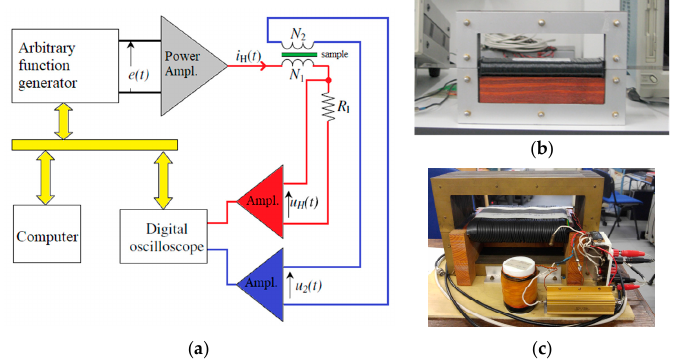
Figure 1. Digital wattmeter set-up ( a ) block-diagram [14], ( b ) first yoke for 30 × 300 mm 2 samples, ( c ) second yoke for 60 × 300 mm 2 samples.